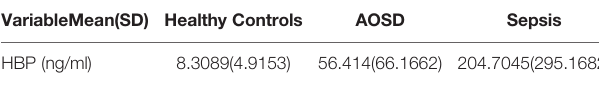
TABLE 2 | Serum heparin-binding protein (HBP) levels in patients with adult- onset Still ’ s disease (AOSD), those with sepsis, and healthy control